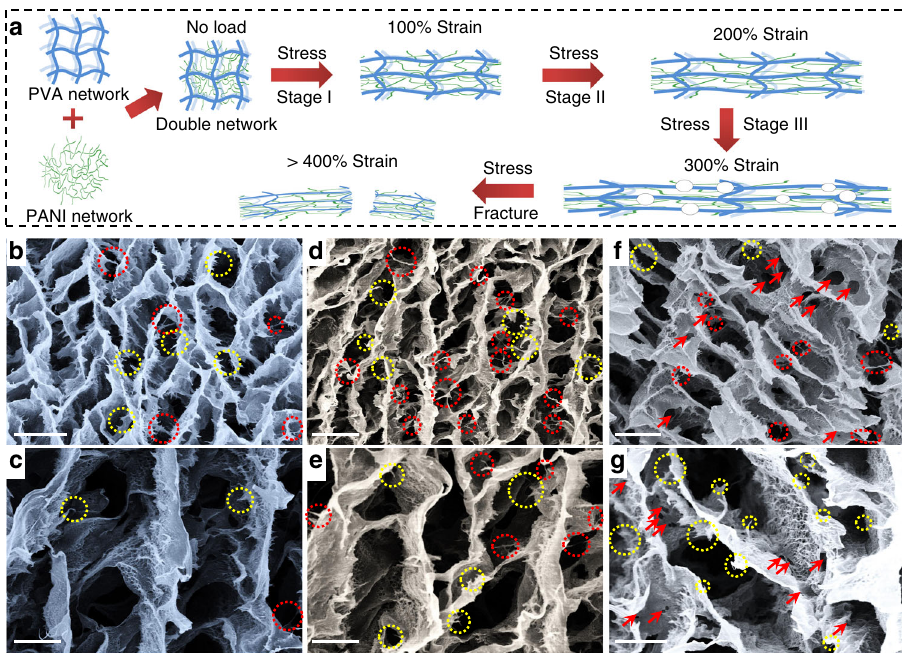
Fig. 4 Strengthening and toughening mechanism. a Schematic illustration of the stretching process of the anisotropic polyvinyl alcohol/polyaniline hydrogel-2 (APPH-2). Ex-situ scanning electron microscopy (SEM) observations of the APPH-2 stretched at the strain of b , c 100%, d , e 200%, and f , g 300%. Scale bars: b , d , f 10 μ m, respectively; c , e , g 4 μ m,